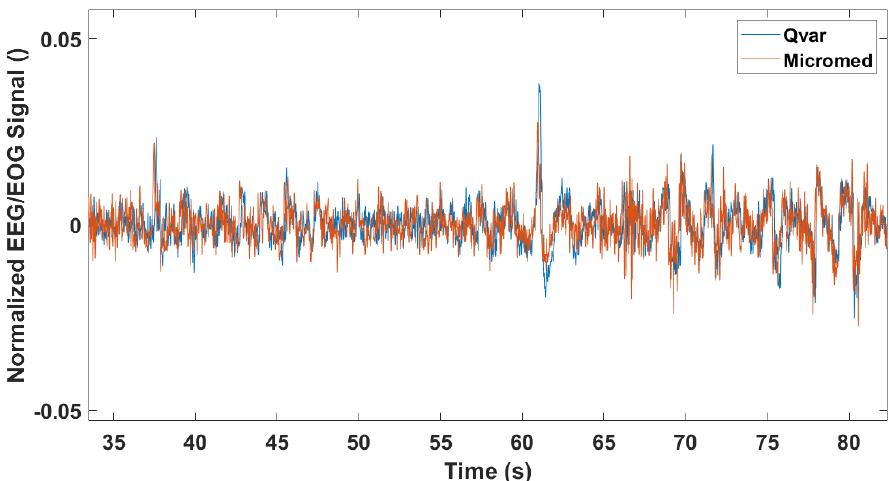
Figure 15. MicroMed vs. ST−Qvar raw traces from frontal single-channel EEG acquisition.